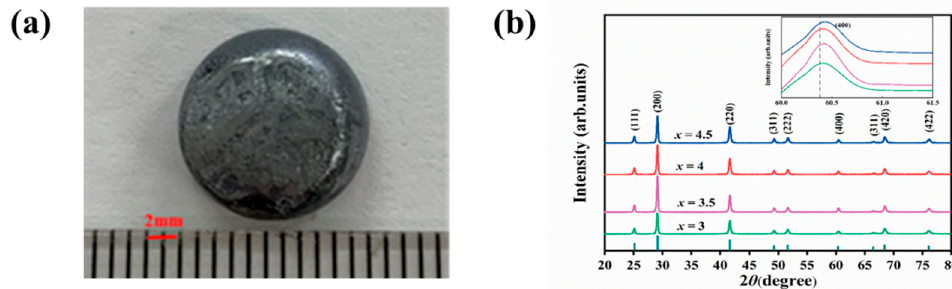
Figure 1. External appearance picture and X-ray diffraction patterns. ( a ) The photograph of PbSe(NaCl) 3 synthesized using the sodium chloride fusion approach. ( b ) XRD patterns of PbSe(NaCl) x (x = 3, 3.5, 4, 4.5) with the standard XRD spectrum of PbSe for comparison.